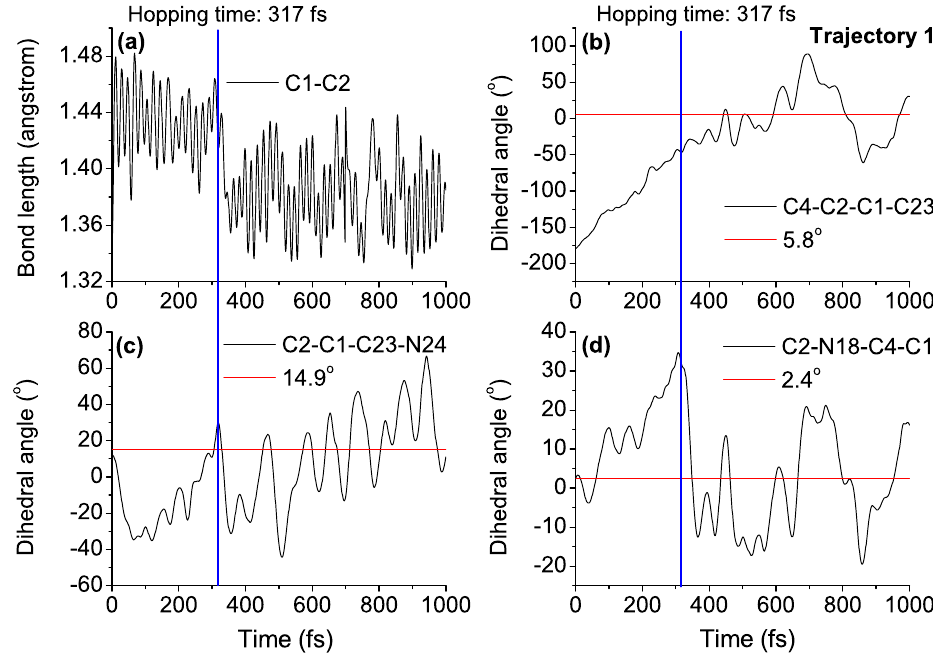
Figure 9. Time dependence of ( a ) central bond length C1-C2; ( b ) central dihedral angle C4-C2-C1- C23; ( c ) side dihedral angle C2-C1-C23-N24; and ( d ) pyramid dihedral angle C2-N18-C4-C1 in a representative trajectory (named as trajectory 1) of ZP → EP photoisomerization process. The S 1 → S 0 hopping time (blue line) and correponding geometrical parameters of reaction product EP isomer (red lines) are also shown in the